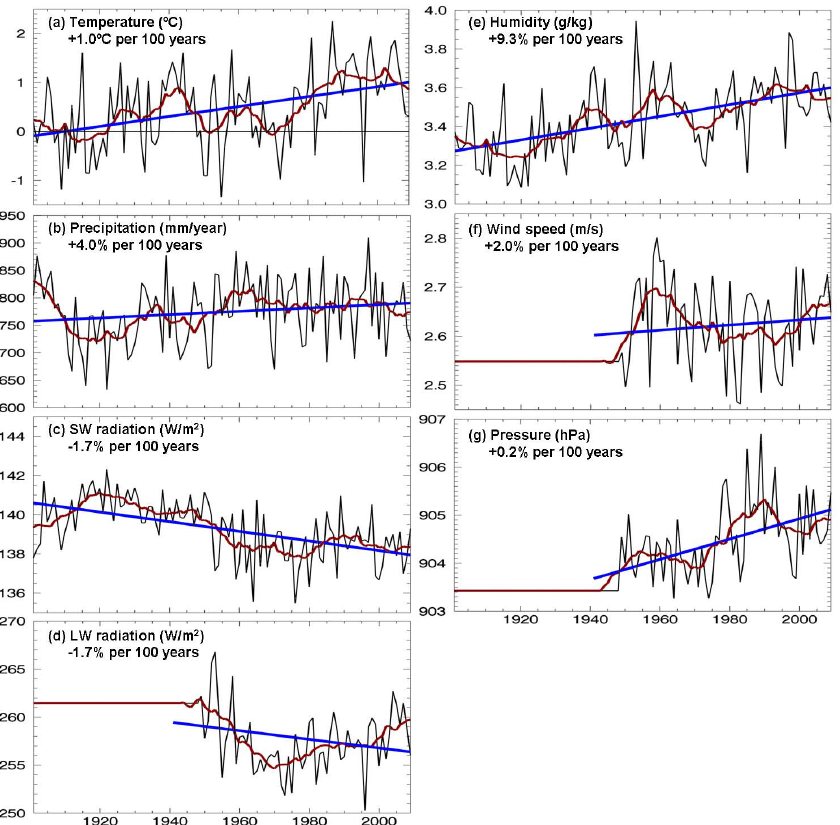
Fig. 2. BC province-wide averaged climate variables from the CRUNCEP data that are used to drive CLASS and CTEM models for the period 1901 to 2010. The dark-red curves are 10yr moving averages and the blue lines are linear trends whose values are also noted. The trend values are normalized to change per